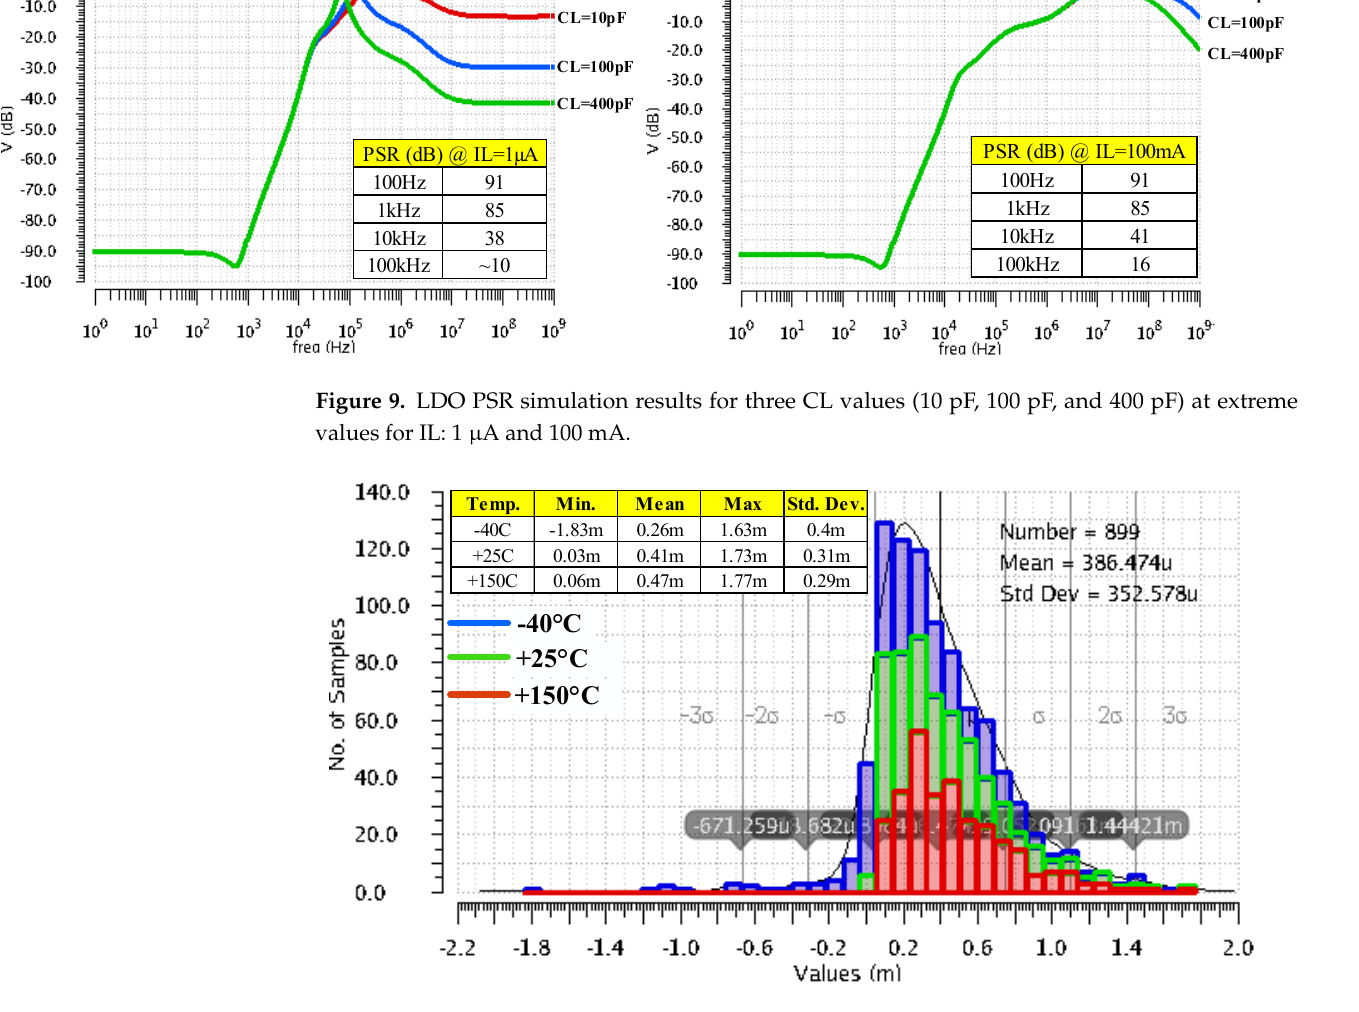
Figure 10. Variation of the LDO output voltage when VIN changes its value from 1.25 V to 1.5 V, while the load current is kept constant, IL = 1 mA. Results yielded by 300 Monte Carlo simulation runs for three temperatures, − 40 °C, +25 °C, and +150 °C.